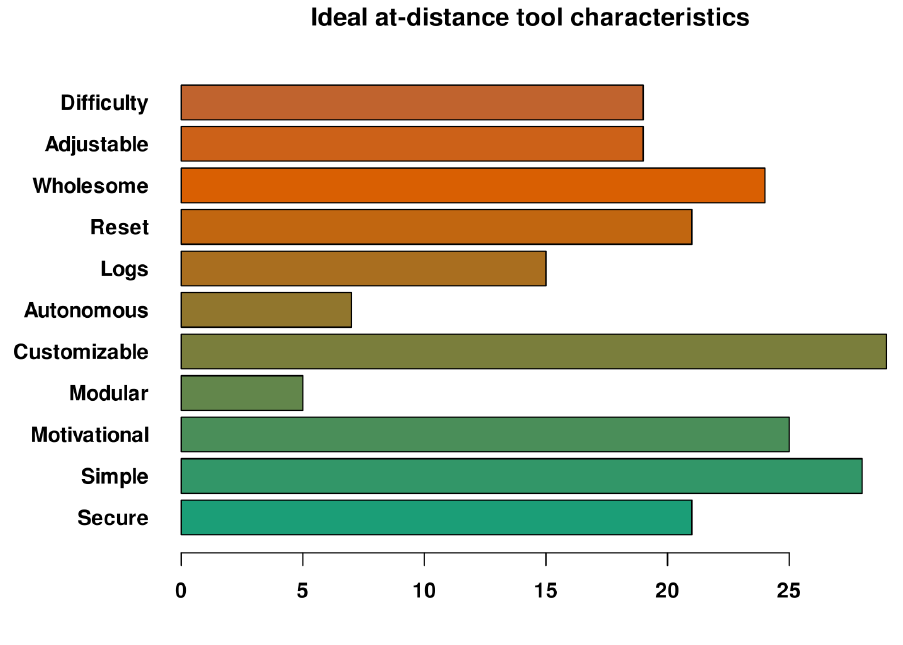
Figure 12. Set of characteristics that an ideal at-distance continuation of intervention tool should